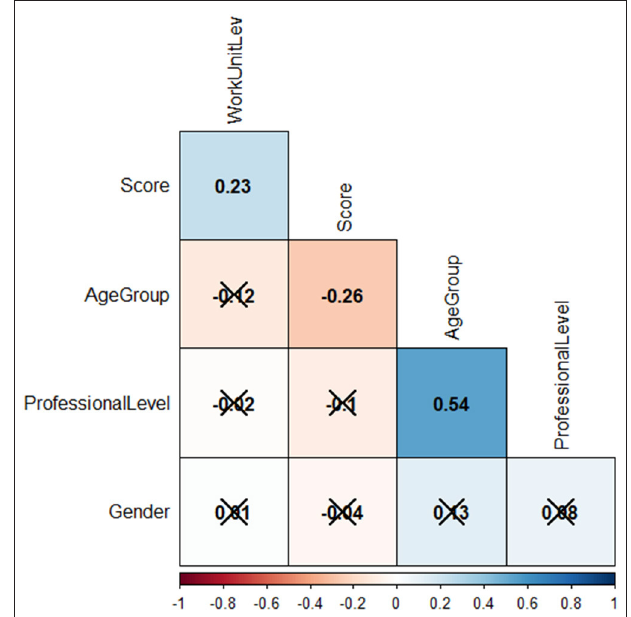
FIGURE 3 | Correlation analysis matrix to the technicians. × indicates P >